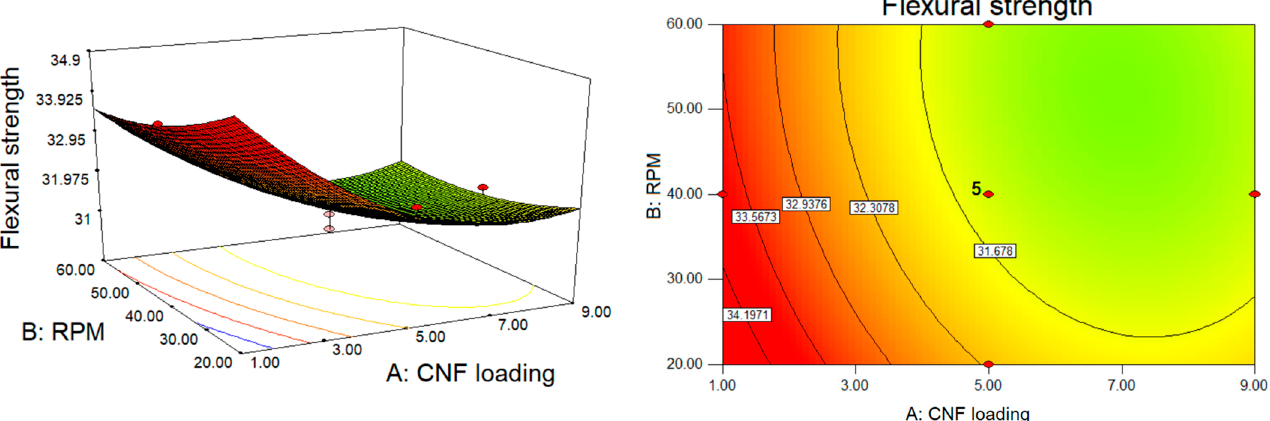
Figure 2. The 3D and response surface contour plots for the dependence of P(HB- co -11% HHx)/CNF bionanocomposite’s tensile strength on CNF loading and temperature as significant factors.